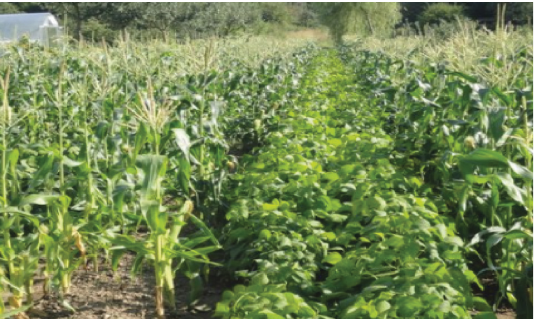
Figure 1: Quality of crop production through crop rotation